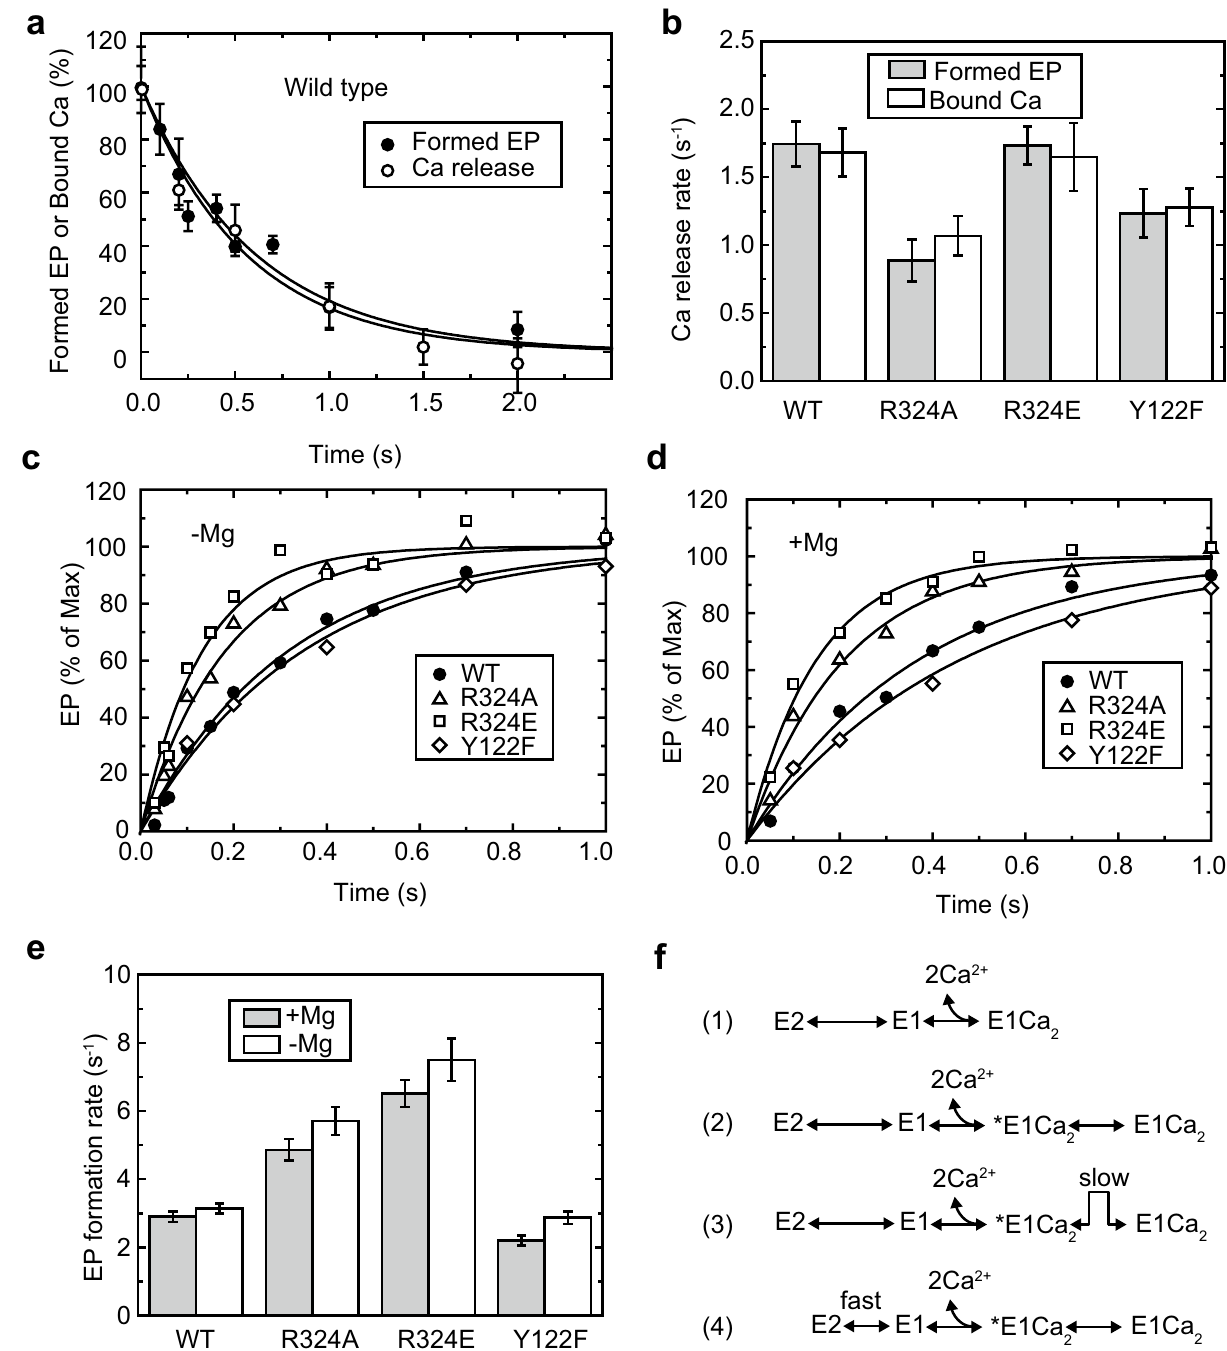
Figure 3. Kinetic analyses of the dissociation and association processes of cytoplasmic Ca 2+ . ( a ) Time courses of Ca 2+ release from E1Ca 2 in microsomes prepared from COS-1 cells expressing wild-type SERCA1a, estimated from EP formation activity (closed symbols) or bound Ca 2+ (open symbols) at 4 °C. The solid lines shows the least squares fit to a single exponential decay. ( b ) Rate constants of Ca 2+ release from SERCA1a wild-type or mutants obtained from a (± standard deviation) from at least three experiments. The gray bars indicate estimated values from formed EP and the open bars from bound Ca 2 + . ( c, d ) Microsomes (20 μg/ml) were incubated in medium containing 50 mM MOPS/Tris (pH 7.0) and 0.1 M KCl in the presence of 7 mM MgCl 2 and 1.2 mM EGTA ( c ) or 0.2 mM EDTA without MgCl 2 ( d ) at 4 °C. EP formation was initiated by addition of medium containing MgCl 2 , CaCl 2 , and [γ- 32 P]ATP. Final concentrations of Mg 2+ , Ca 2+ , and ATP in the reaction medium were 7 mM, 0.4 mM, and 10 μM, respectively. The reaction was terminated with 7% TCA (final concentration) at the indicated time points after ATP addition and the amount of EP was measured. The solid lines show the least squares fit to a single exponential increase from 0 time. ( e ) Rate constants obtained from c and d (± standard error of the mean). The parameters are listed in Supplementary Table S3. ( f ) Reaction schemes of the E2 to E1Ca 2 transition